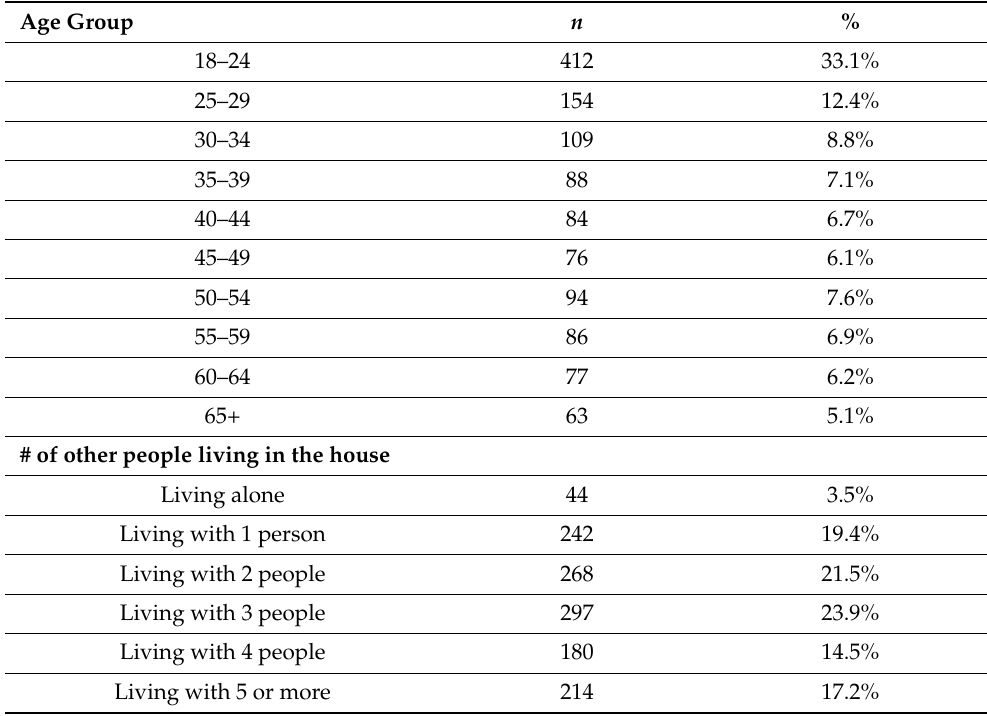
Table 1. Summary of the sociodemographic characteristics of online survey respondents, women living in Mexico City ( n = 1245) June